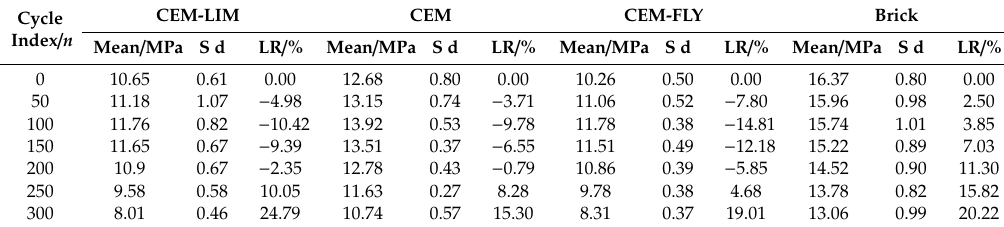
Table 6. Index properties for mortar prisms and